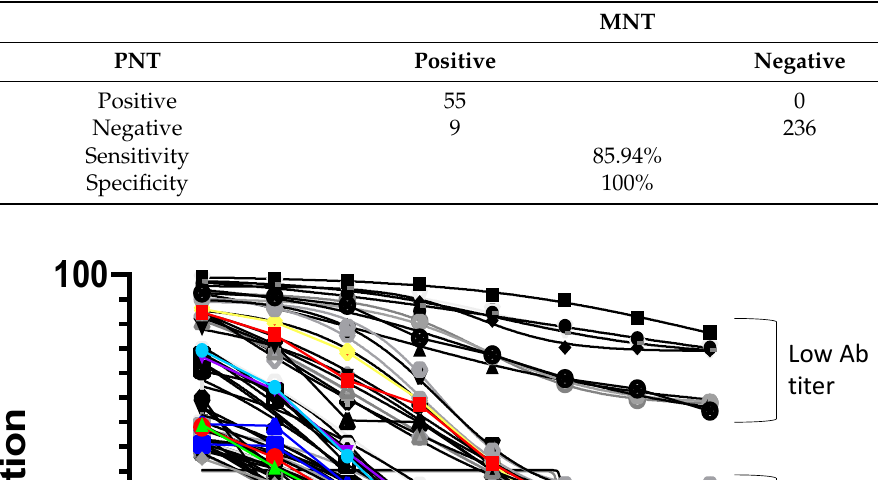
Table 2. Sensitivity and specificity of the pseudotyped viral particles assay.